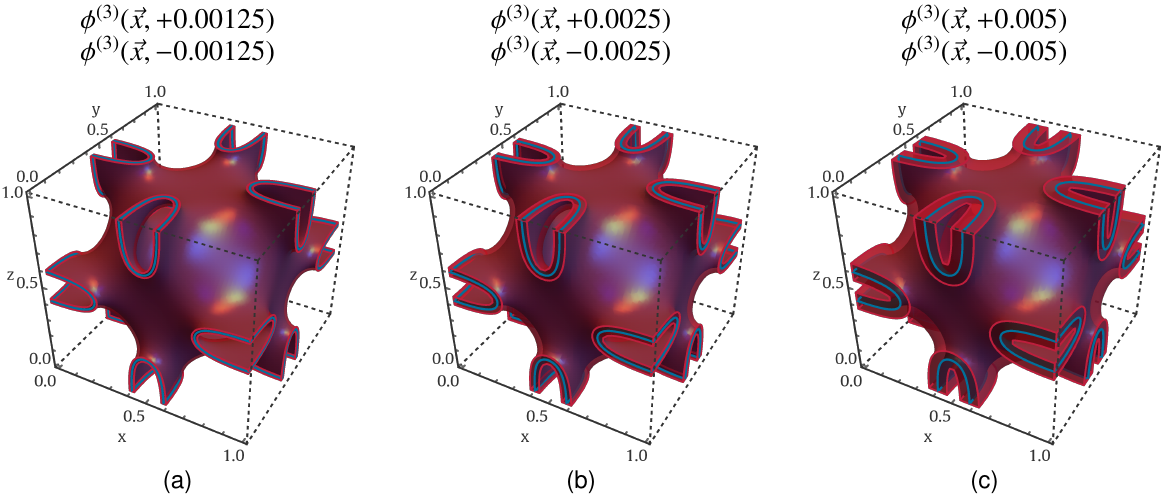
Figure 6. Infill volume enclosed between two offset contours from the original Neovius interface F Neo ( (cid:126) x ) = 0. For a unit cell, the offset distance is 0.00125 in ( a ), 0.0025 in ( b ), and 0.005 in ( c ). The third-order offset function was